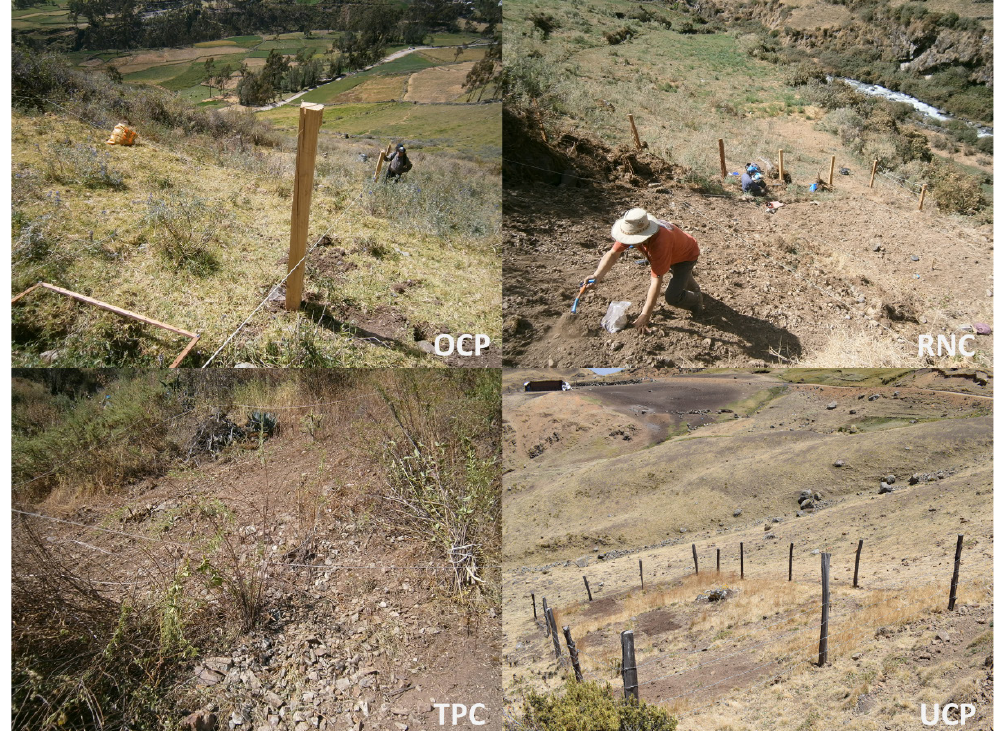
Figure 2. Long-term plots for the monitoring of induced post-agricultural